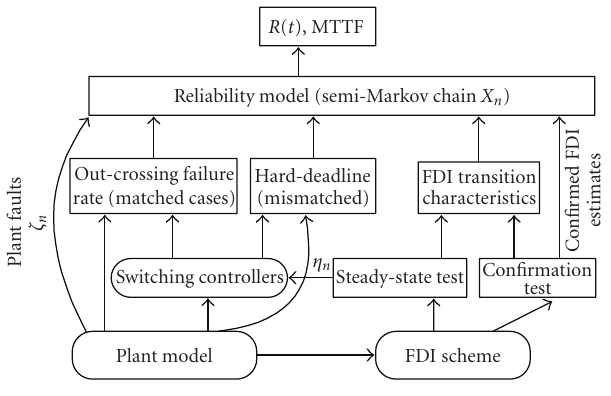
Figure 2: System structure.